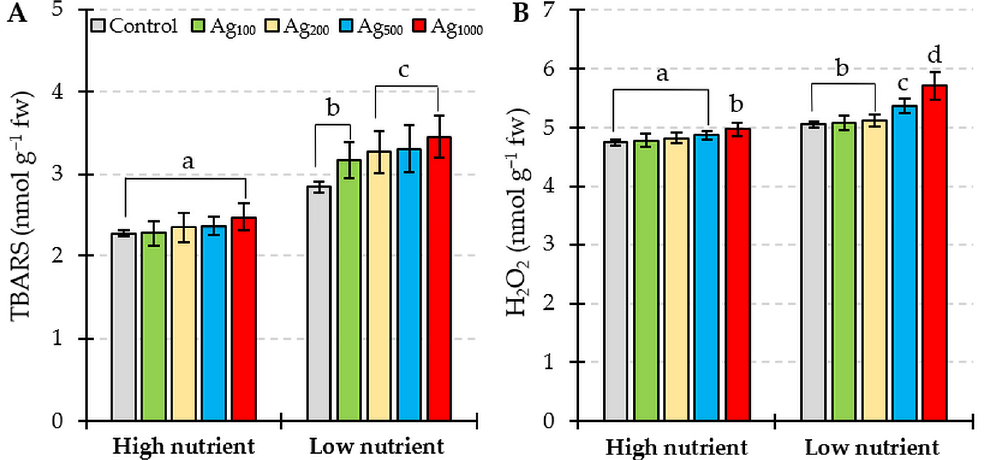
Figure 3. ( A ) TBARS and ( B ) H 2 O 2 concentration in L. gibba exposed to a two-hour pulse of different colloidal silver concentrations (control = 0 µ g/L; Ag 100 = 100 µ g/L; Ag 200 = 200 µ g/L; Ag 500 = 500 µ g/L; Ag 1000 = 1000 µ g/L) combined with two levels of total nitrogen and total phosphorus nutrition (high nutrients; low nutrients). Values shown are mean ± standard deviation of ten replicates ( n = 10). Di ff erent le tt ers indicate signi fi cantly di ff erent values (HSD, p < 0.05).